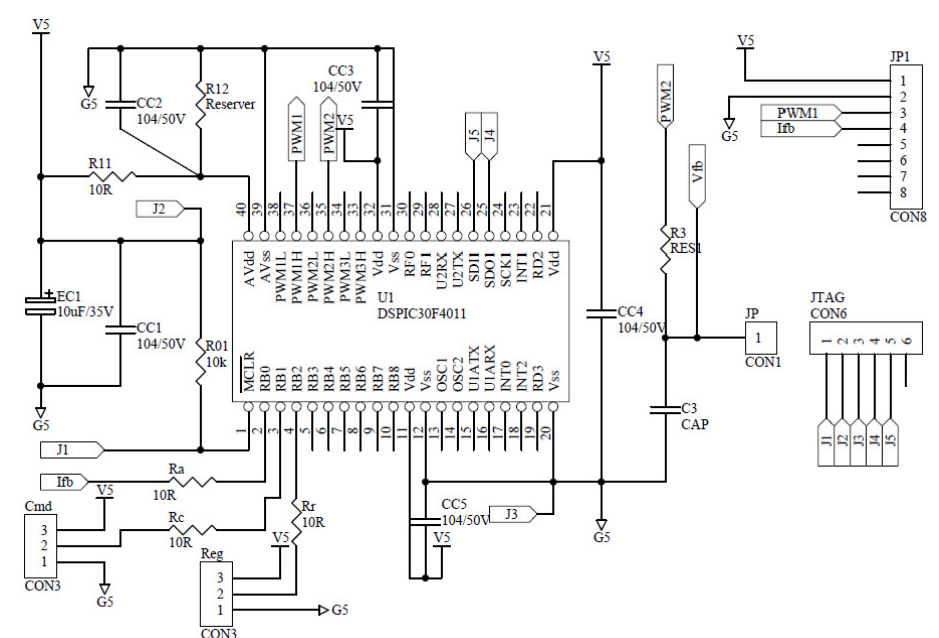
Figure 10. Microchip-dsPIC auxiliary circuit in the